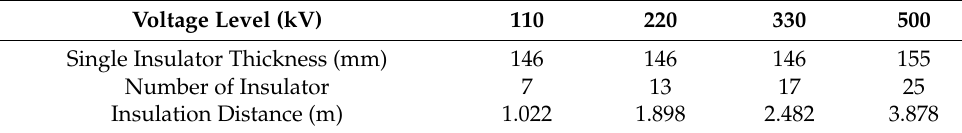
Table 4. Insulation distance under different voltage